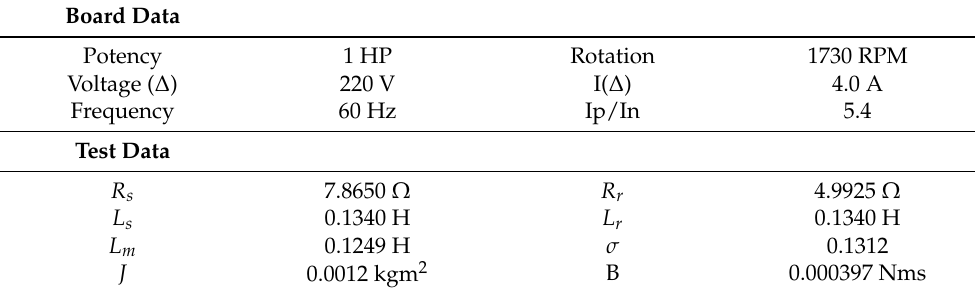
Table 3. Parameters of the motor